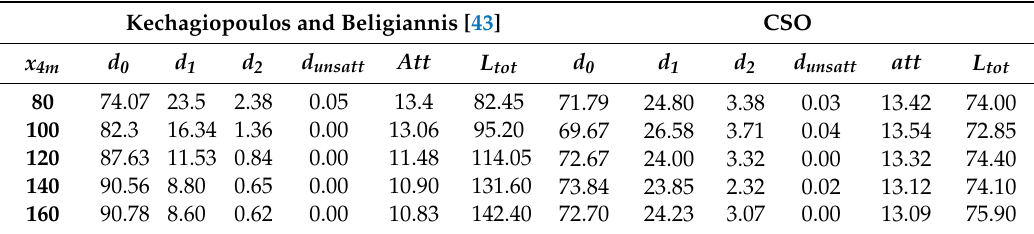
Table 18. Comparative results for providers’ operational cost for a route set with 4 routes and 10 nodes per route (average